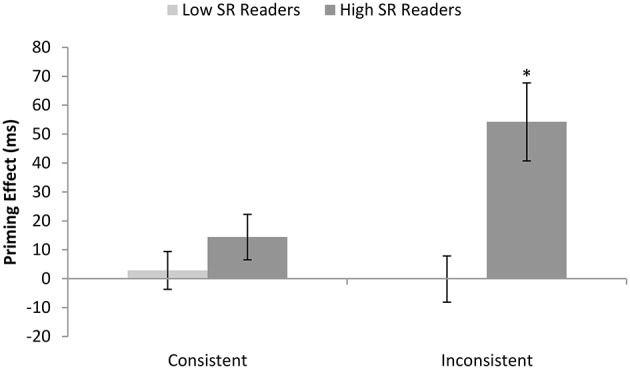
Average priming effect seen in reaction times for each reader group (high vs. low semantic reliance) according to consistency. Error bars represent standard error. Asterisks indicate significant priming effects of p < 0.005.